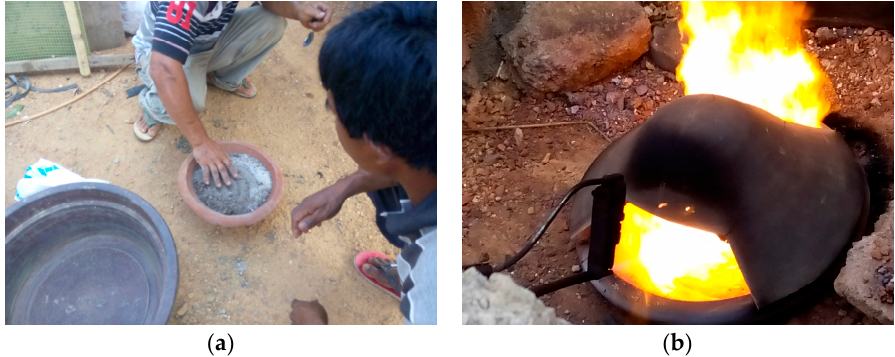
Figure 4. Mixture of plant ash and borax ( a ) and smelting the tobacco ash ( b ).